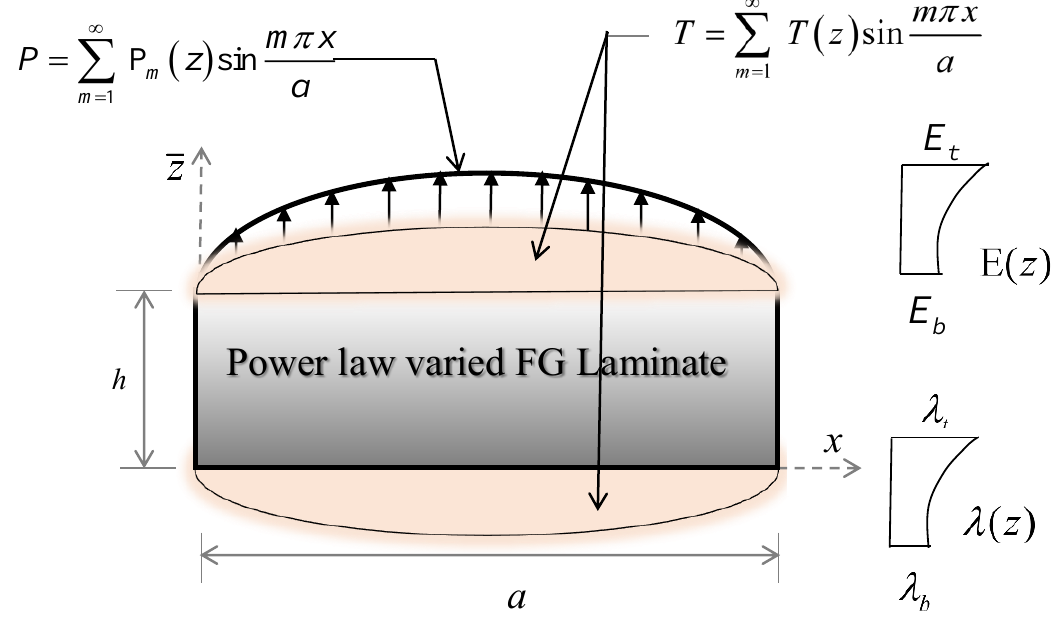
Fig. 1. FG laminate subjected to thermal and/or mechanical